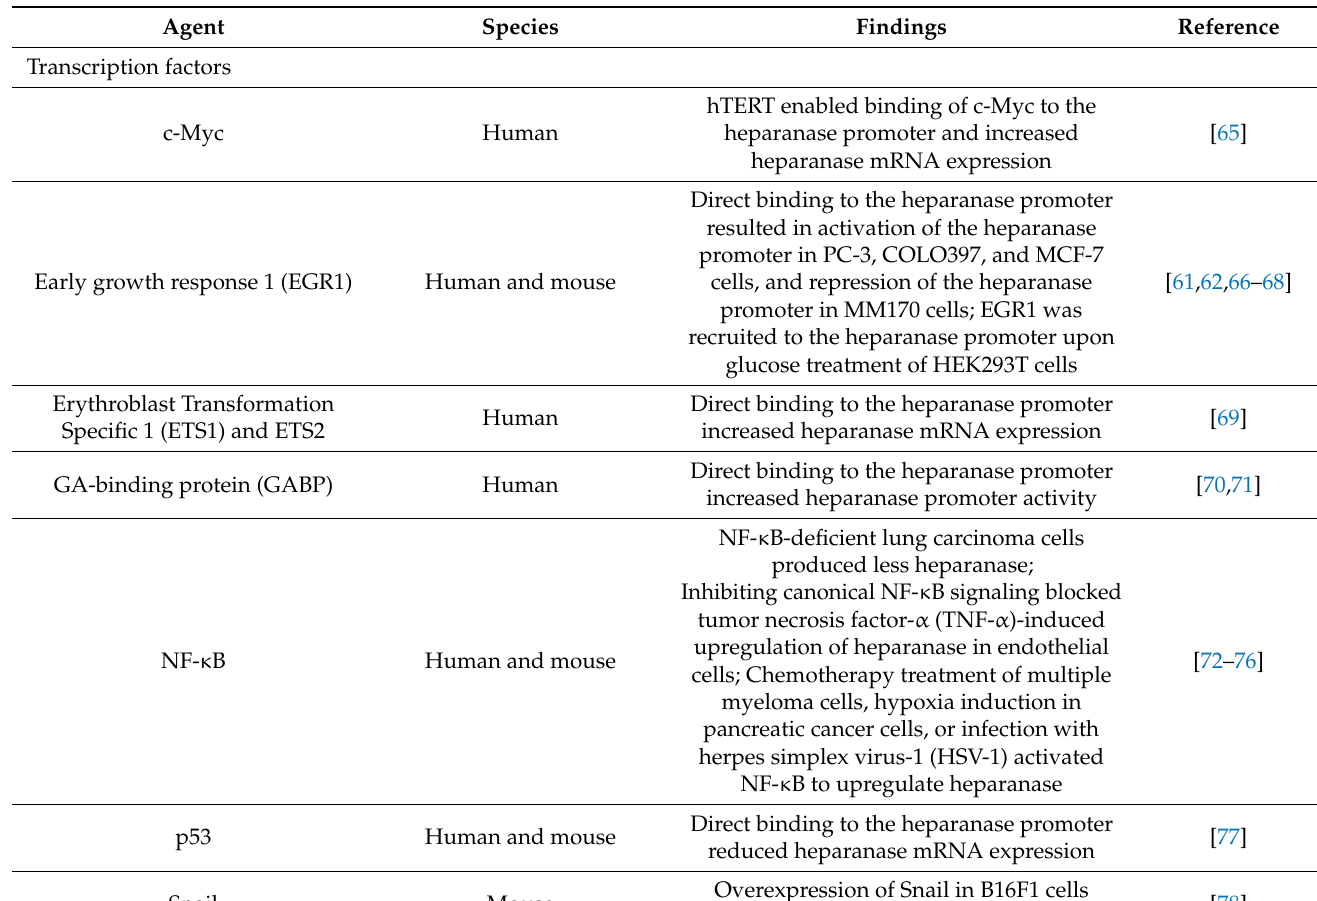
Table 2. Proteins, molecules, pathogens, pathways, and therapeutics that modulate heparanase